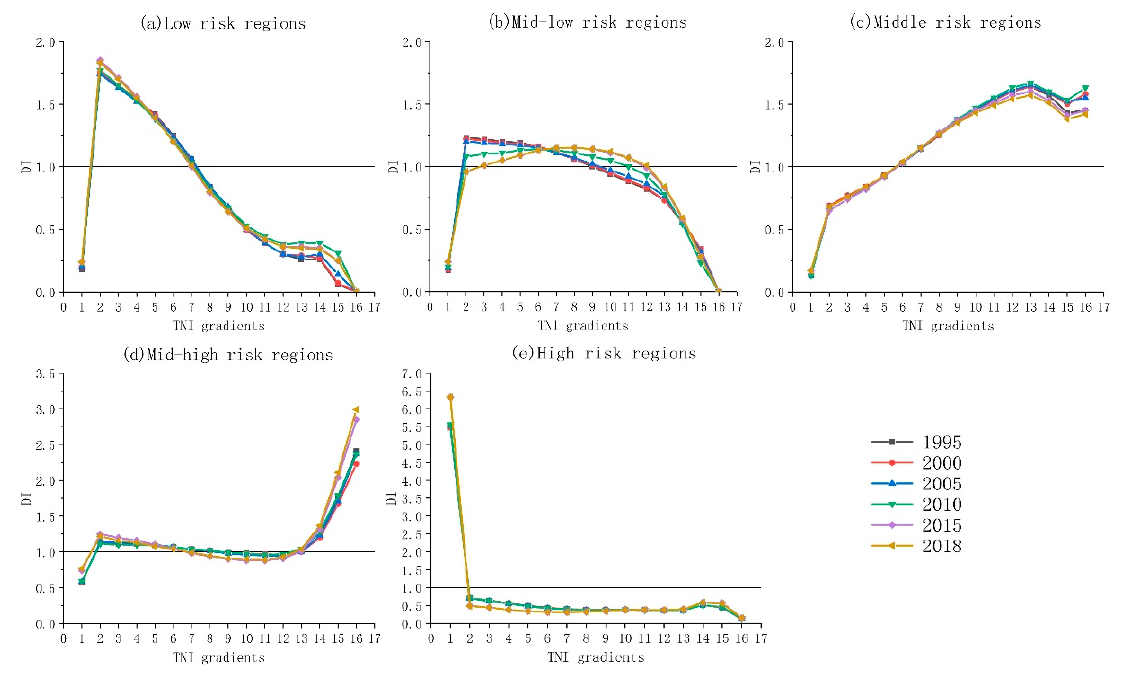
Figure 6. The terrain gradient distribution of LER in the Dianchi Lake basin of China.